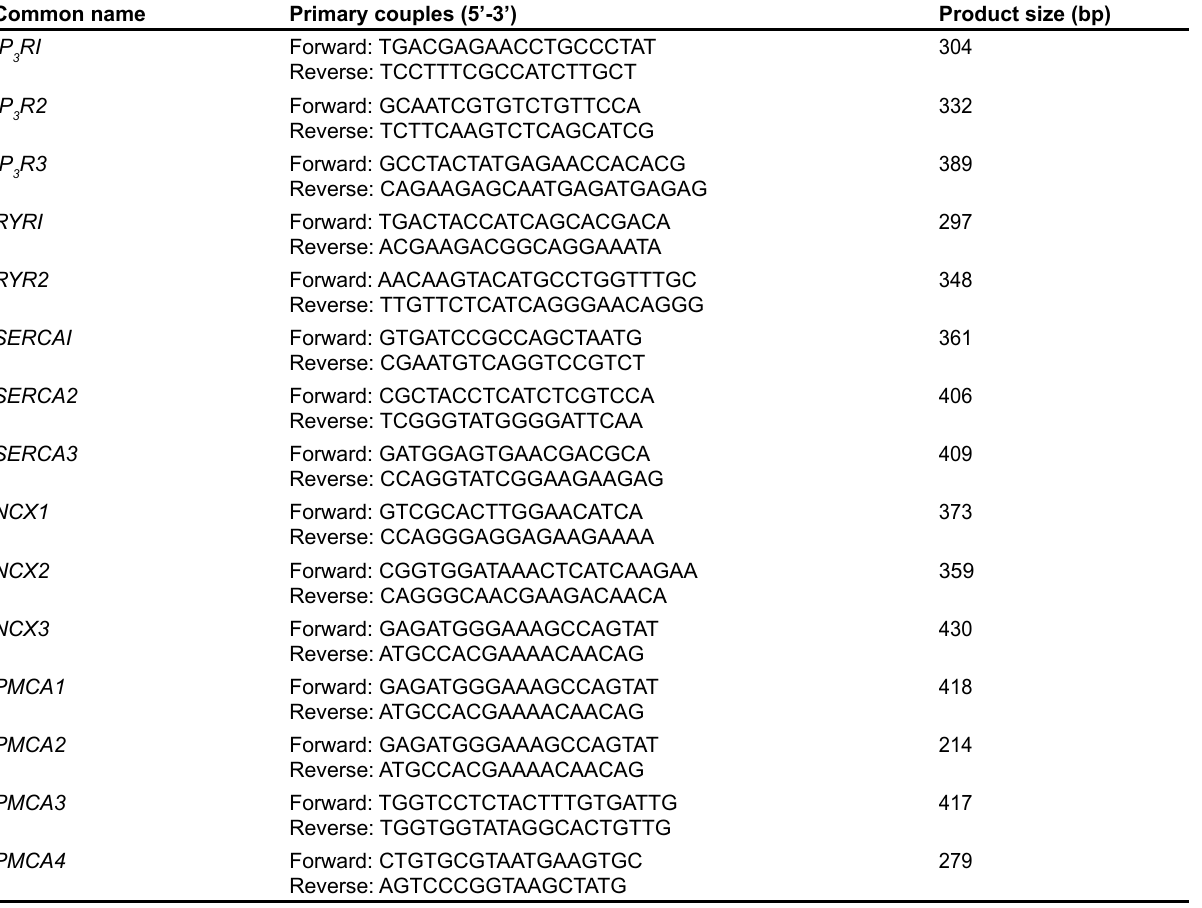
Table 1. Primary sequences of